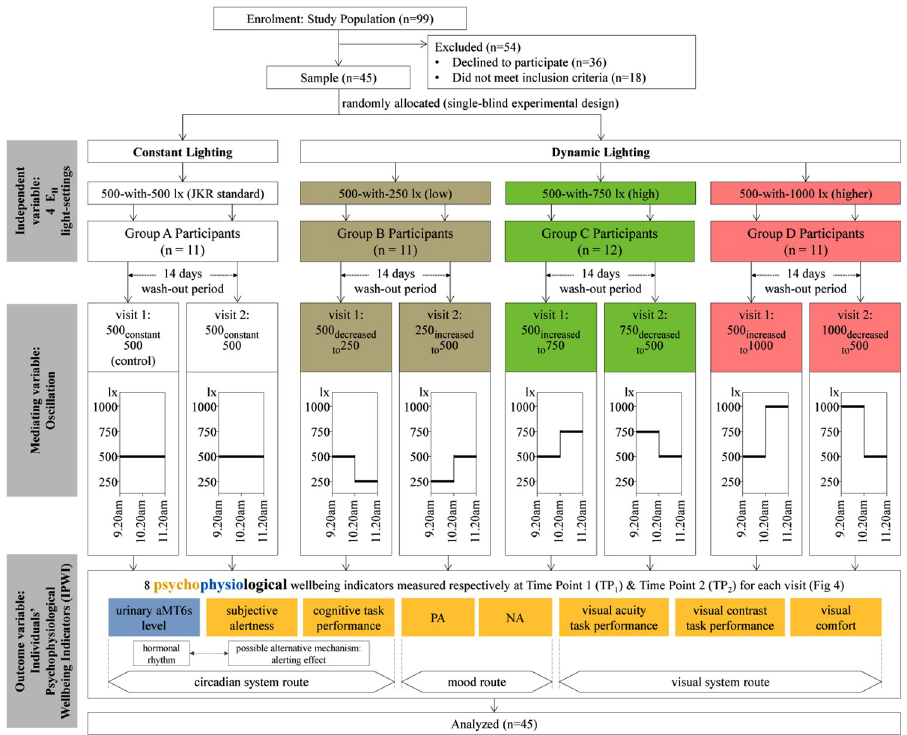
Fig 2. Schematic diagram describing the variables and experimental study